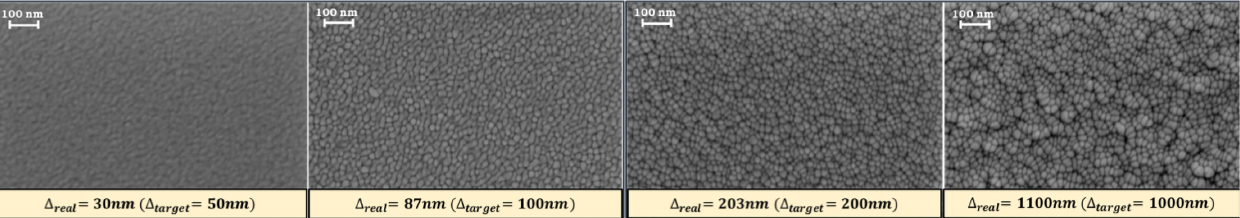
FIG. 7. Morphology of NEG thin films analyzed by SEM.